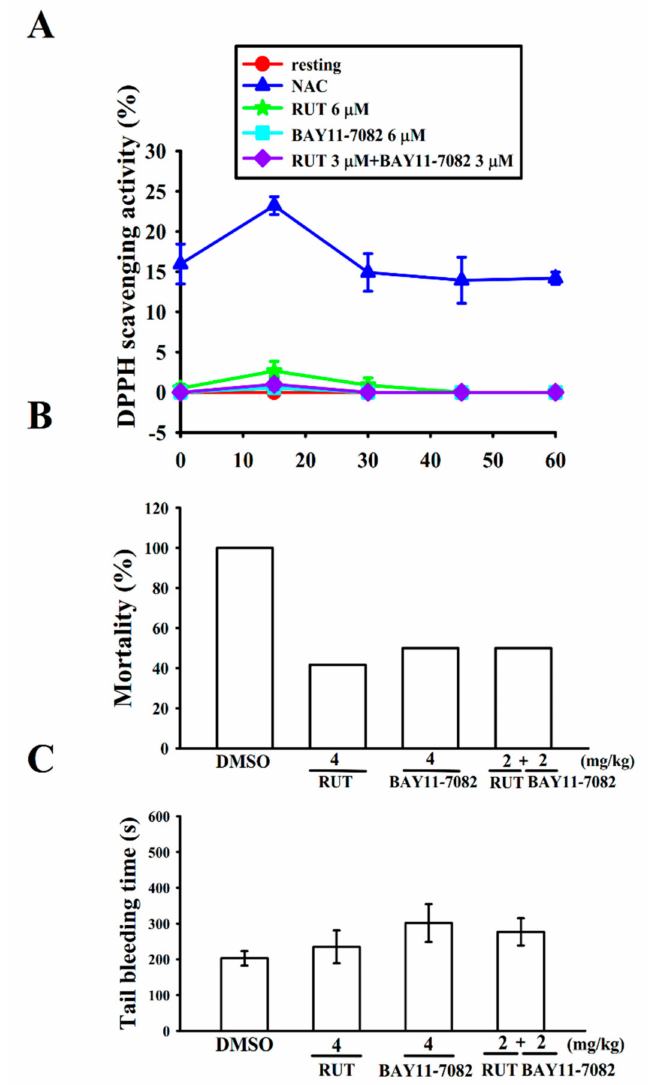
Figure 5. Inhibitory effect of rutaecarpine and BAY11-7082 on free radical formation in the 2,2- diphenyl-1-picrylhydrazyl (DPPH) assay and acute pulmonary thromboembolism as well as tail bleeding time in mice. ( A ) DPPH–methanol (400 µ M) was mixed with rutaecarpine (RUT; 6 µ M) or BAY11-7082 (6 µ M) and then incubated for 30 min. The absorbance at 517 nm was determined using a spectrophotometer. ( B ) Mice were administered an intraperitoneal bolus of the solvent control (0.1% DMSO), RUT (4 mg/kg) or BAY11-7082 (4 mg/kg), or combination of RUT (2 mg/kg) with BAY11-7082 (2 mg/kg), the ADP (700 mg/kg) was then injected into mouse tail vein. The mortality rate of all groups was observed within 10 min after injection. ( C ) The bleeding time was measured through mouse tail transection after 30 min of intraperitoneal administration of the solvent control (0.1% DMSO), RUT (4 mg/kg) or BAY11-7082 (4 mg/kg), or combination of RUT (2 mg/kg) with BAY11-7082 (2 mg/kg). Data are presented as the mean ± standard error of the mean (( A ), n = 4; ( B , C ), n =